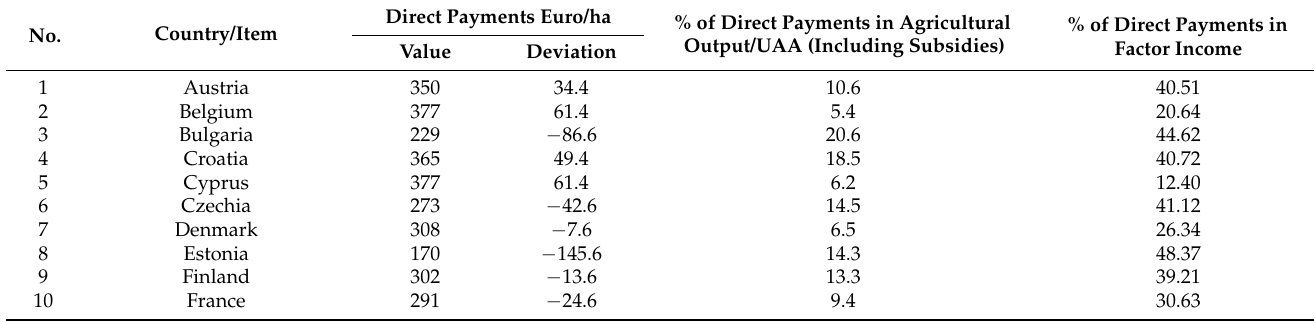
Table 6. Direct payments (euro/ha) and share of direct payments in income